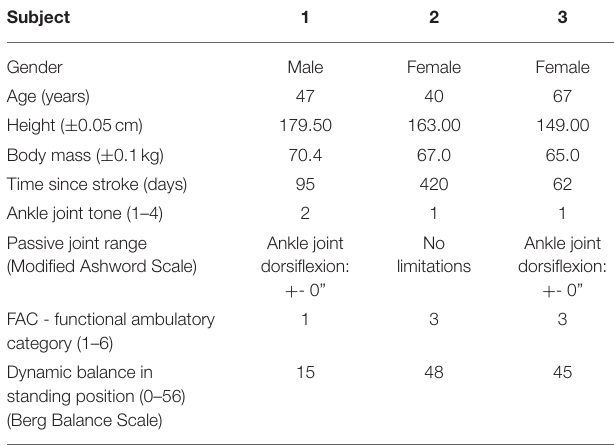
TABLE 2 | Participant’s